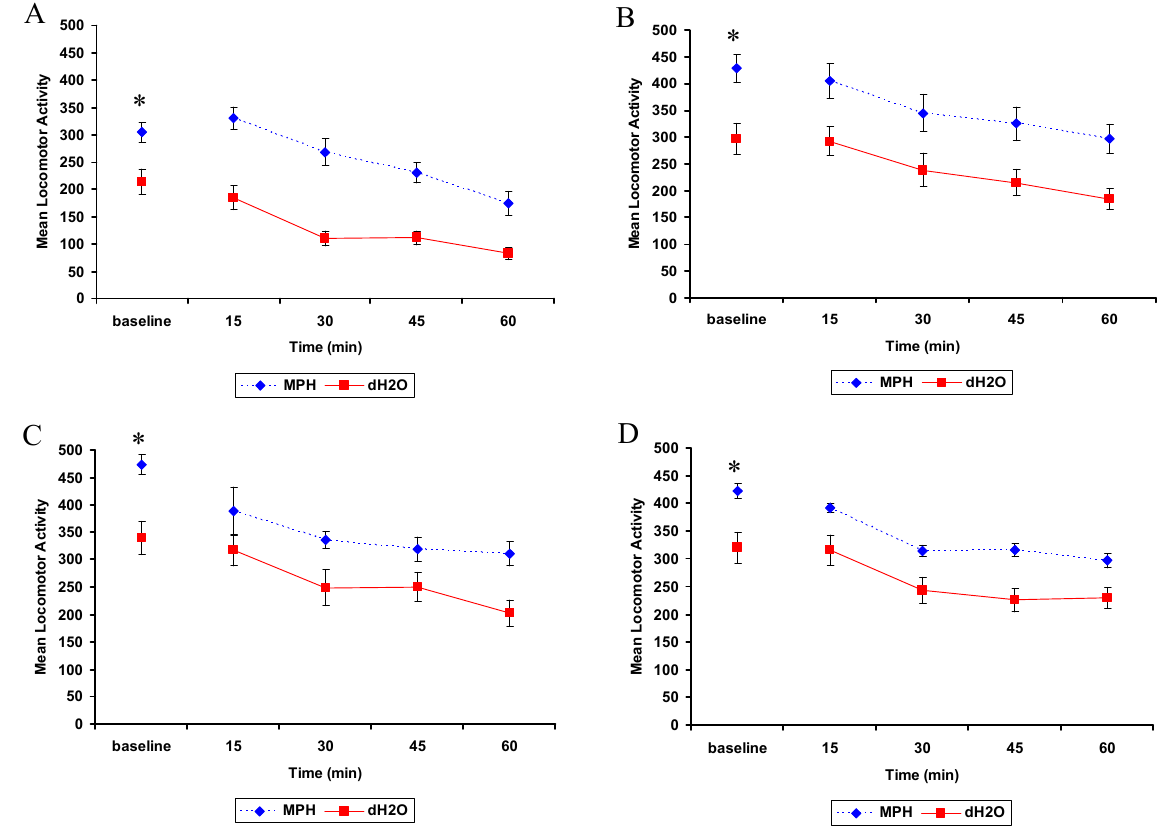
Figure 3. Spontaneously Hypertensive Rats (SHR): Mean (±SEM) locomotor activity at the beginning of each week of oral treatment with 2 mg/kg methylphenidate (MPH; n = 9) or distilled water (dH O; n = 12), measured for 15 min intervals prior to (baseline) and for 2 1 h following treatment in week 1 ( A ); week 2 ( B ); week 3 ( C ); and week 4 ( D